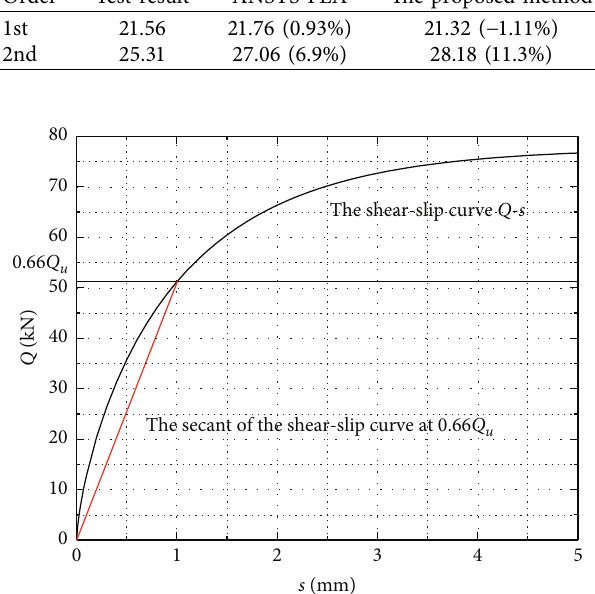
Table 1: A comparison between the eigenfrequencies. Order